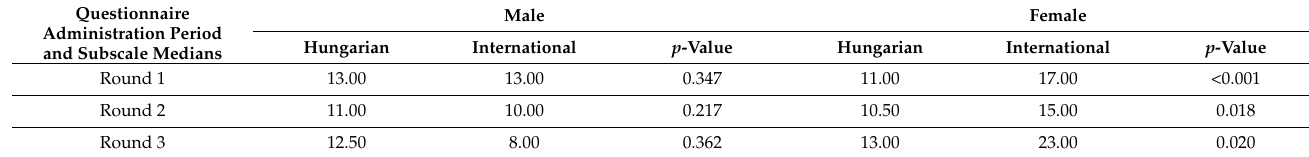
Table 5. Male and female depression scores.